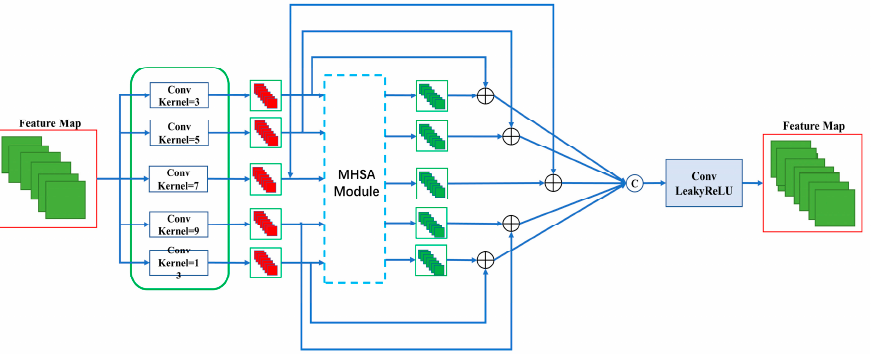
Figure 5. Network Structure of the MBCMHSA-Net.